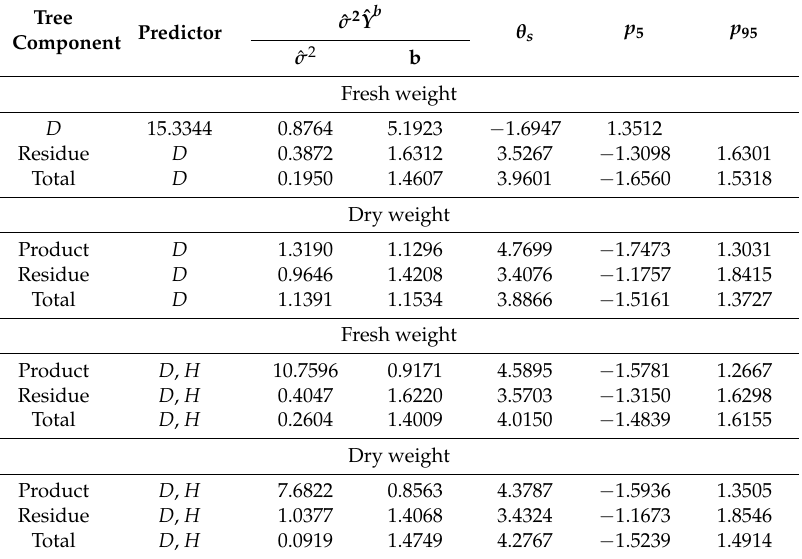
Table 5. Estimated scale factors ˆ σ 2 and exponents of the residual variance functions for product, residue and total tree fresh and dry weight predicted by the system of additive equations without the incorporation of dummy variables for stand types, firstly using D as the independent variable (Equation (6)) and secondly using D and H as the predictors (Equation (8)). θ s is Snowdon’s bias correction factor, p 5 and p 95 are the fifth and ninety-fifth percentiles of the weighted residuals. Tree Component Predictor